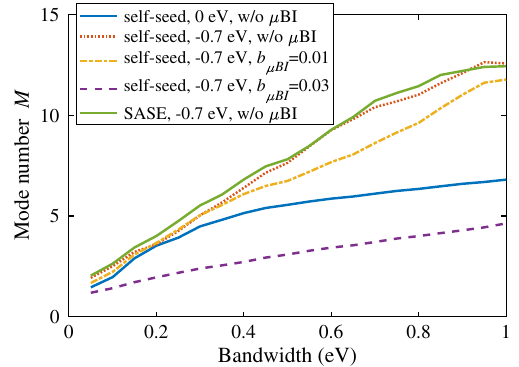
FIG. 4. Histograms of the normalized integrated spectral intensity within full SASE bandwidth (blue bars) and empirically derived probability density function (red curves) using Eq. (3) for self-seeding (top) and SASE (bottom) at z ¼ 48 m.